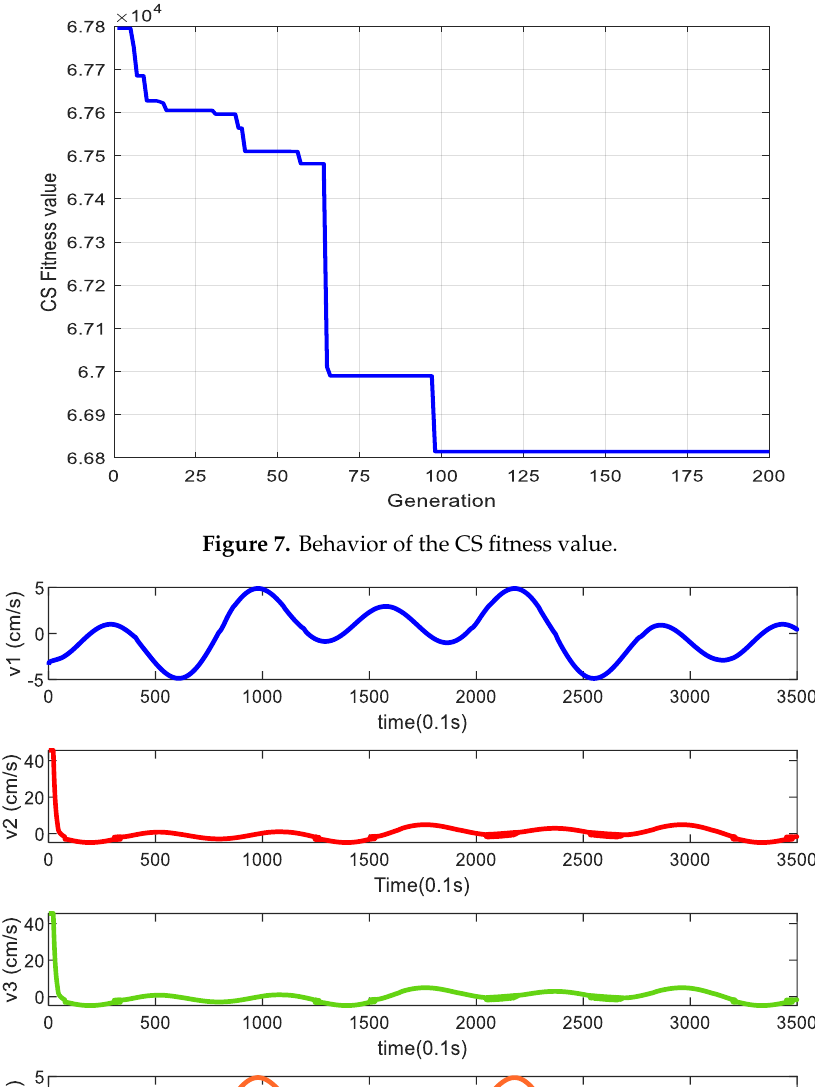
Figure 6. Experimental tracking errors of the position and orientation of the omni-Mecanum-vehicle.